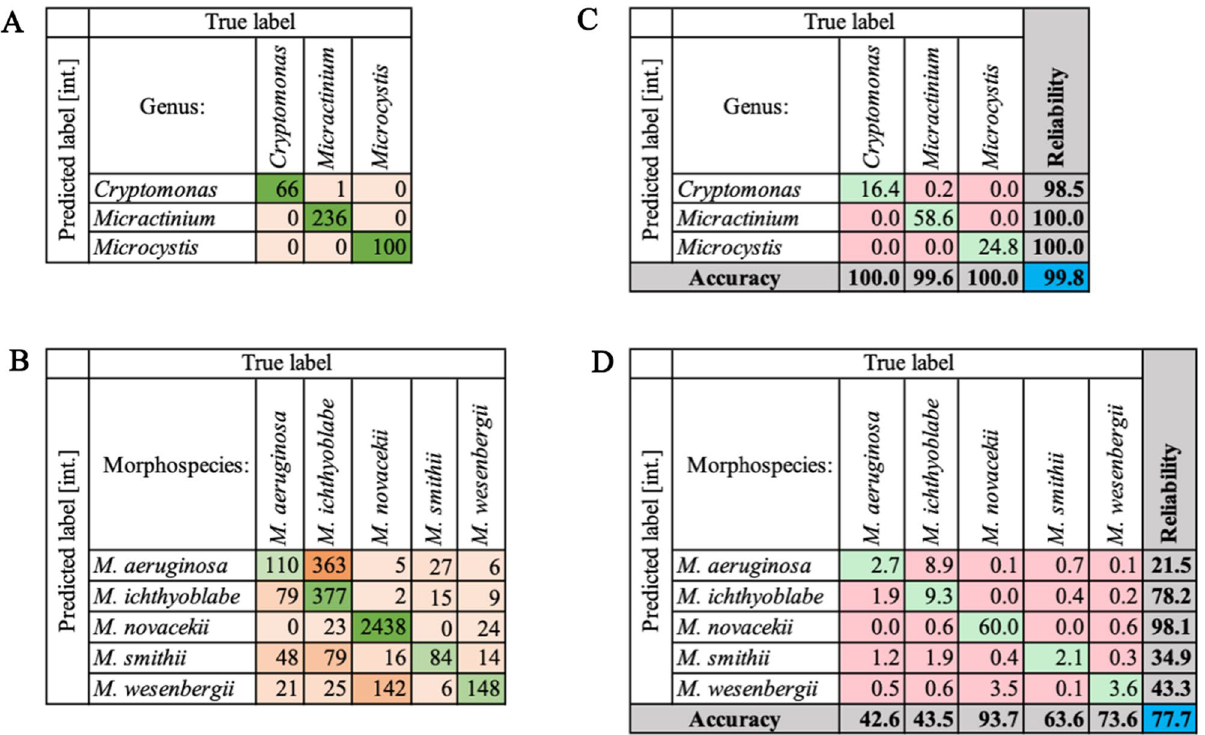
Table 3. The results of classification using intersecting ranges for the intergeneric classification of three classes (upper row) and the intrageneric classification of five Microcystis morphospecies (lower row). (A, B) Numbers represent results when corresponding classifier was applied. Confusion matrices for used filter sets with precision values for correct predictions (highlighted in green) and false discovery rate for misclassifications (highlighted in orange). The coloring was assigned depending on relative frequency in each column. (C, D) Percentage values for accuracy and reliability (precision) of used methods. Overall performance for intergeneric and intrageneric classification in percentage is highlighted in blue.